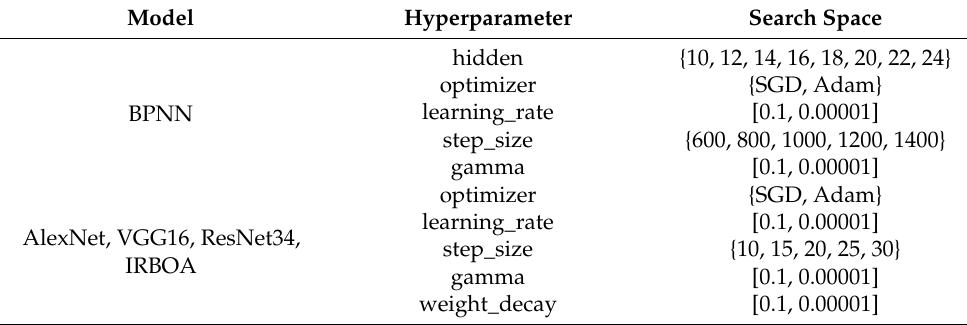
Table 2. Hyperparameters search space based on